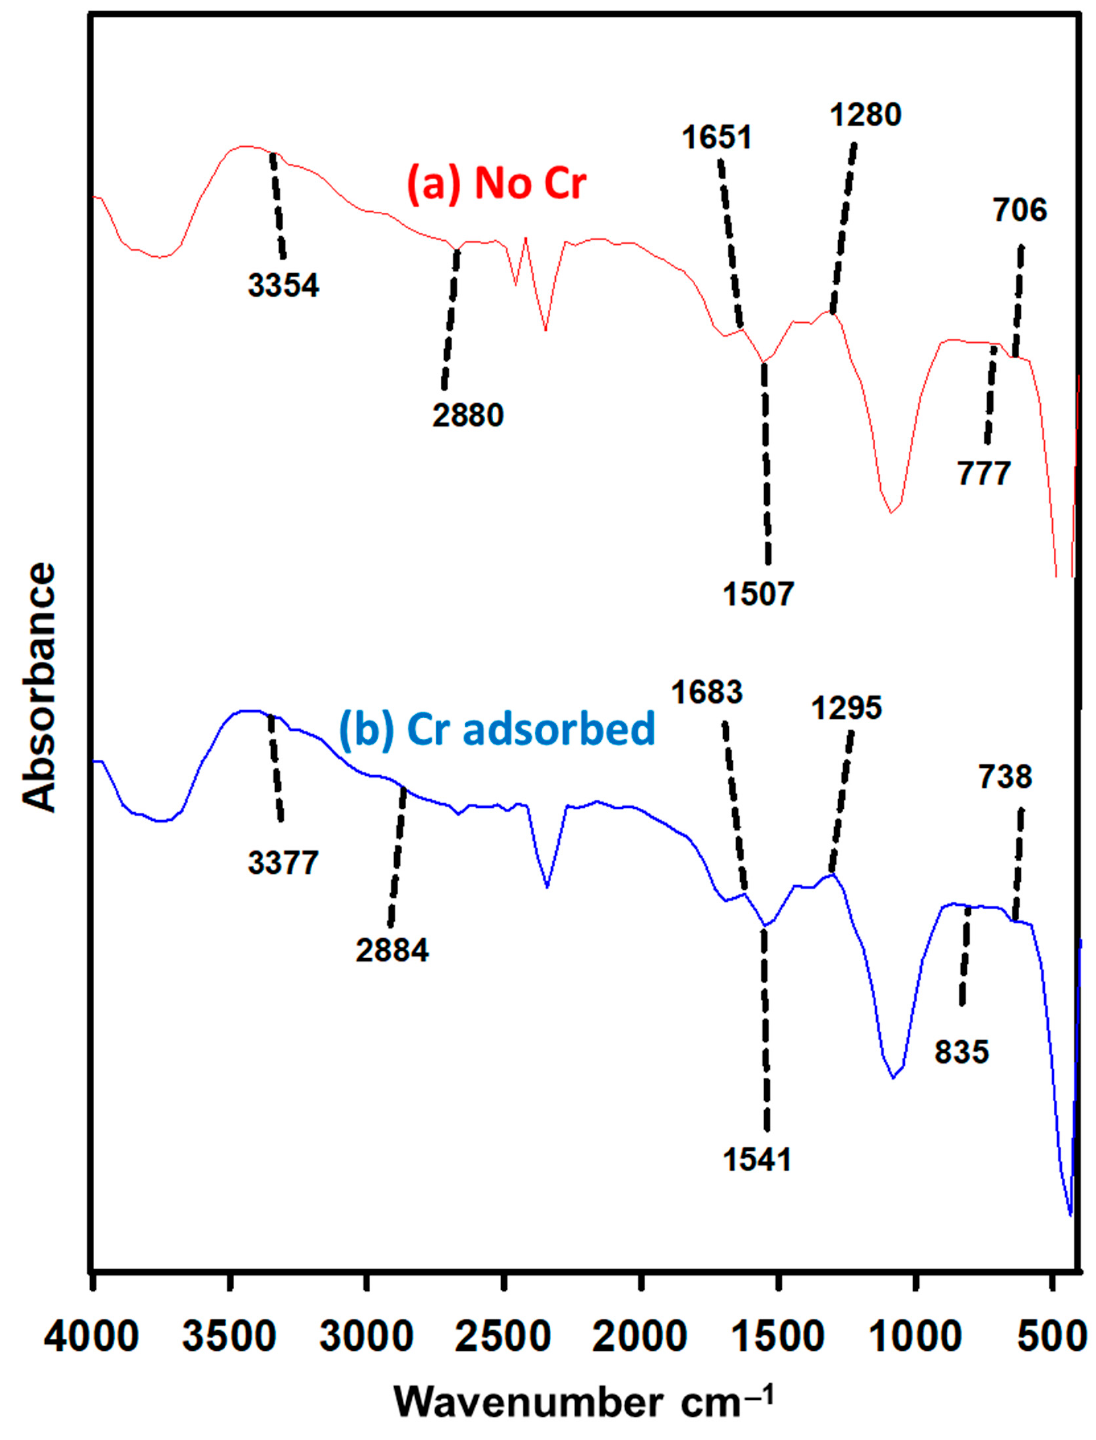
Figure 5. The FTIR spectra of rice husk ( a ) no Cr(VI); ( b ) Cr(VI) ‐ adsorbed. The FTIR spectral peaks of natural rice husk at 3354, 2880, 1651, 1507, 1280, 777 and 706 cm − 1 were shifted to the peaks 3377, 2884, 1685, 1541, 1295, 835 and 738 cm − 1 after